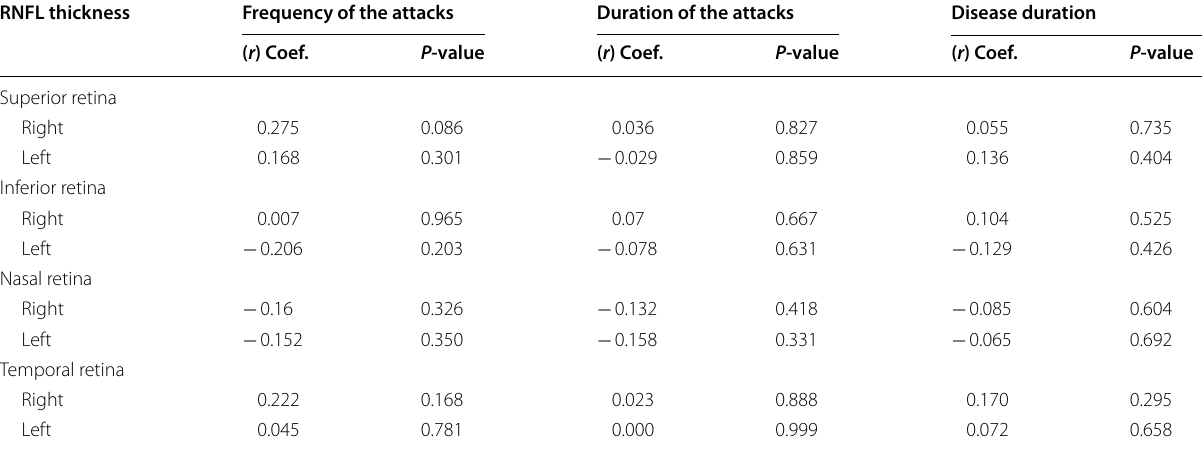
RNFL retinal nerve fiber layer thickness, r correlation coefficient P -value 0.05 is considered ≤